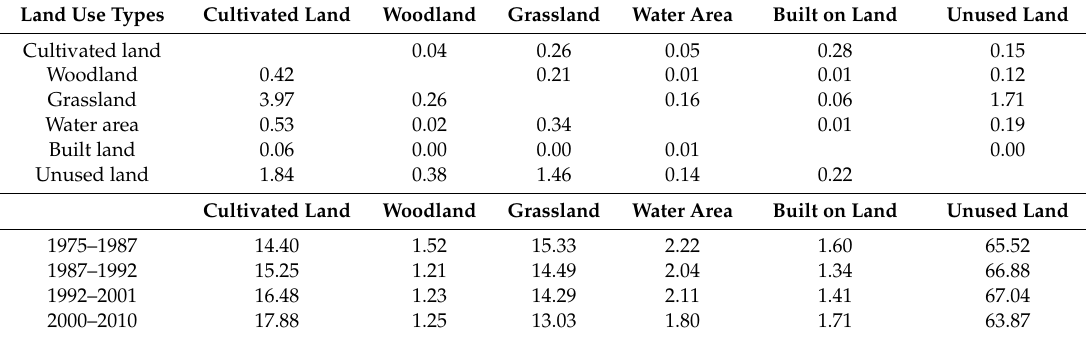
Table 5. Transition matrix and the primary types of land use changes in the middle Heihe River Basin (MHRB) 1975–2010 (10 4 ha 2